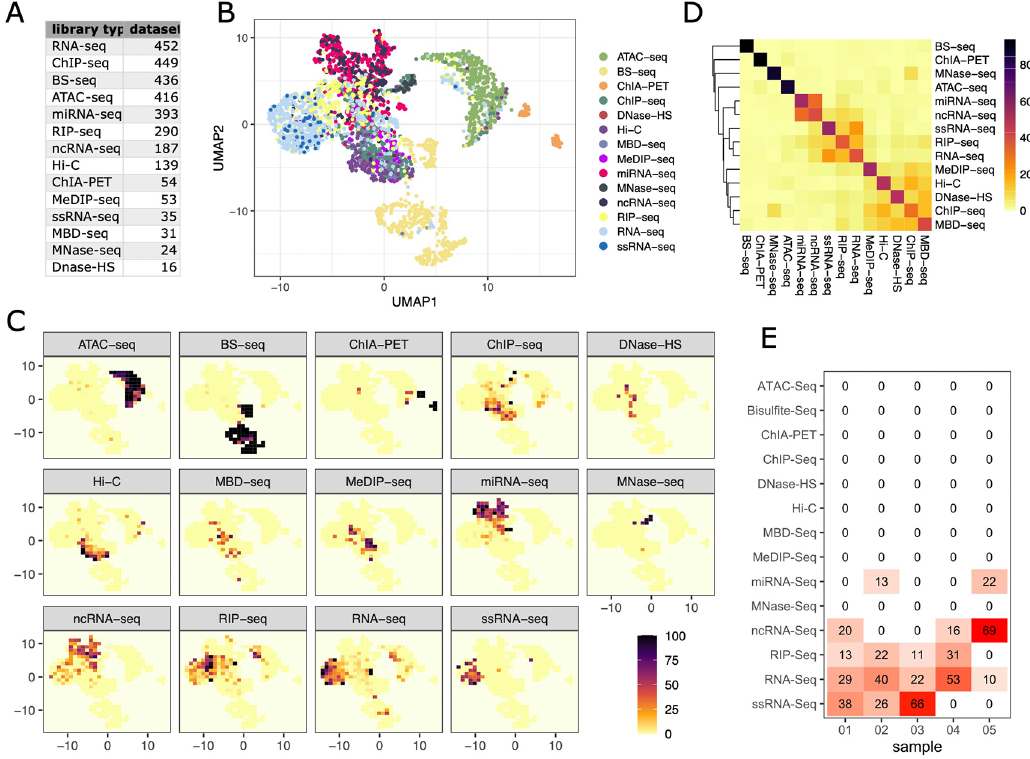
Figure 2. Library types can be distinguished by their base compositions. A) Number of samples per library type included in the analysis. B) UMAP representation of library compositions (reference map). C) Tile based probability map for each library type. Colour represents the percentage of a particular library type per tile. D) Heatmap illustratingthe specificity of each librarytype for tiles of the reference map. All samples were assigned to areference maptileand colourrepresentsthe averagepercentageof eachlibrarytype forthesetiles. E) Librariantile probability output: Percent of each library found in the reference map tile associated with the test